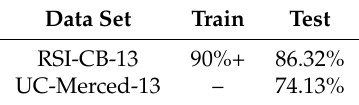
Table 8. Test results based on AlexNet-Conv3 for RSI-CB-13 and